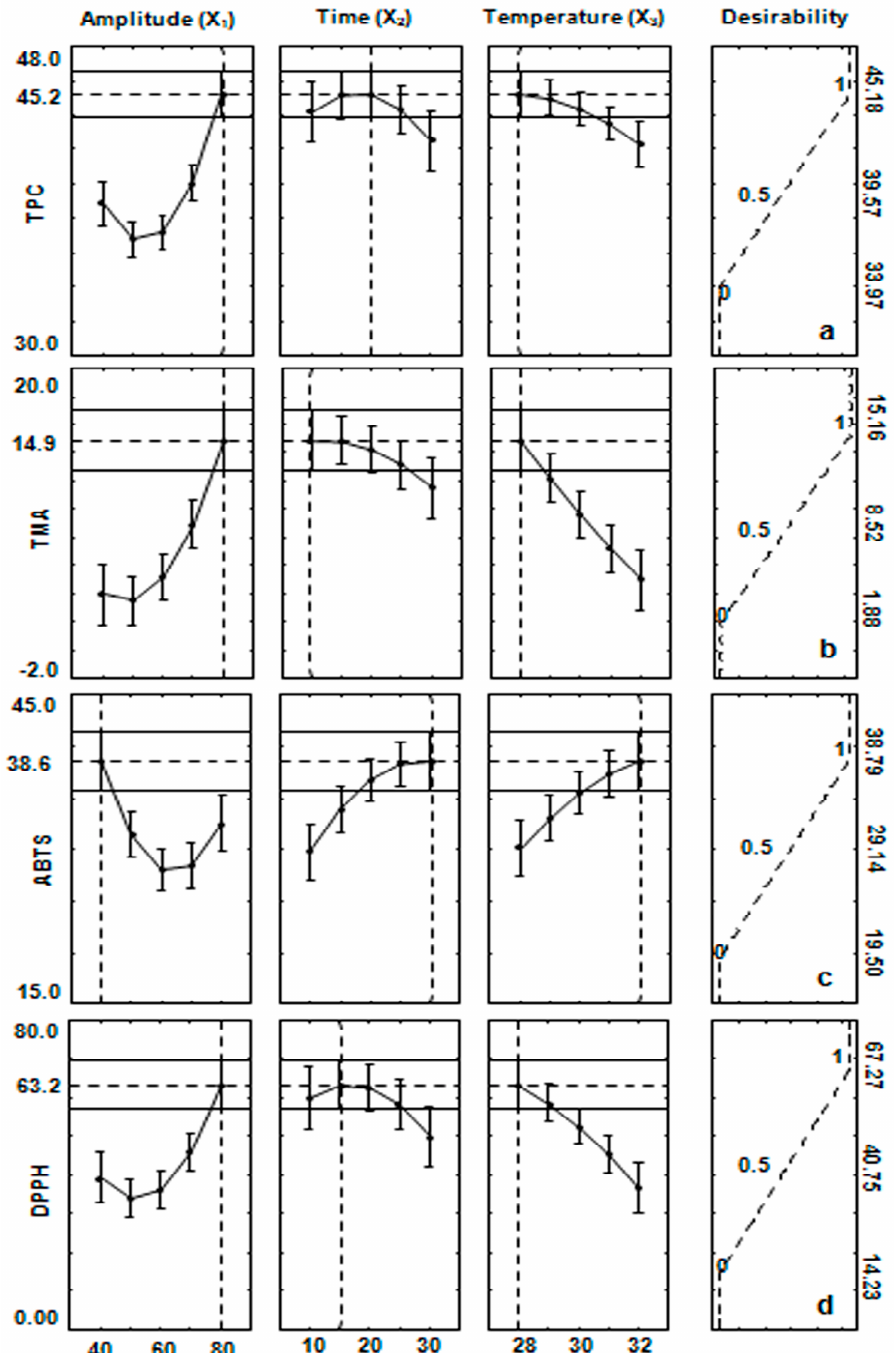
Figure 4. Profiles for predicted values and desirability function for the average recovery of ( a ) total soluble phenol content (TPC); ( b ) total monomeric anthocyanin content (TMA); ( c ) ABTS, and ( d ) DPPH of the leaf extract of Brosimum alicastrum . Dashed lines indicate the optimization values.